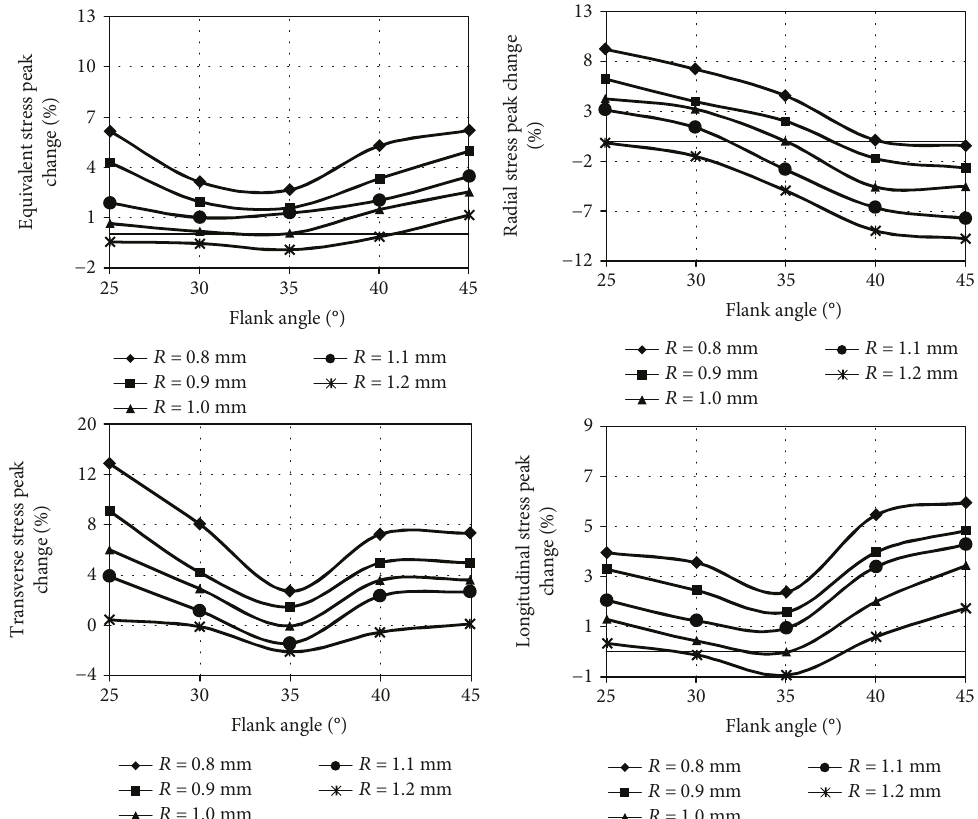
Figure 11: The in fl uence of fl ank angle and rounding arc on stress peaks during implant loading with loads generated during heel